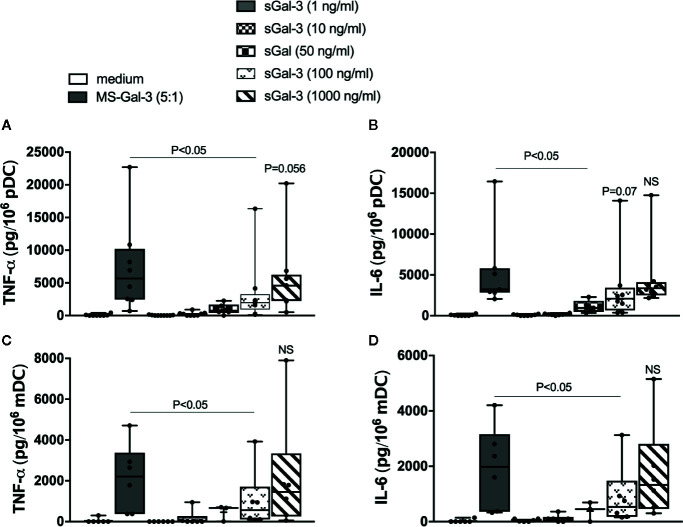
Gal-3 activates human blood dendritic cell (DC) subtypes for pro-inflammatory cytokines: matrix-bound vs. solution. rhGal-3 was passively absorbed onto 5μm-sized microspheres (MS-Gal-3), as described in the Material and Methods section, or directly added to culture medium (sGal-3) at the indicated concentrations. Human plasmacytoid DCs (pDCs) (A, B) and myeloid DC (mDC) (C, D) were then co-cultured with MS-Gal-3 at a 5:1 ratio (MS:DC) or directly added to increasing concentrations of sGal-3 or medium alone. Cell culture supernatants were then harvested after 20h incubation and assayed for TNF-α and IL-6 by ELISA. Results are shown in Box-Whisker plots representing results from different DC preparations (n=3–8).